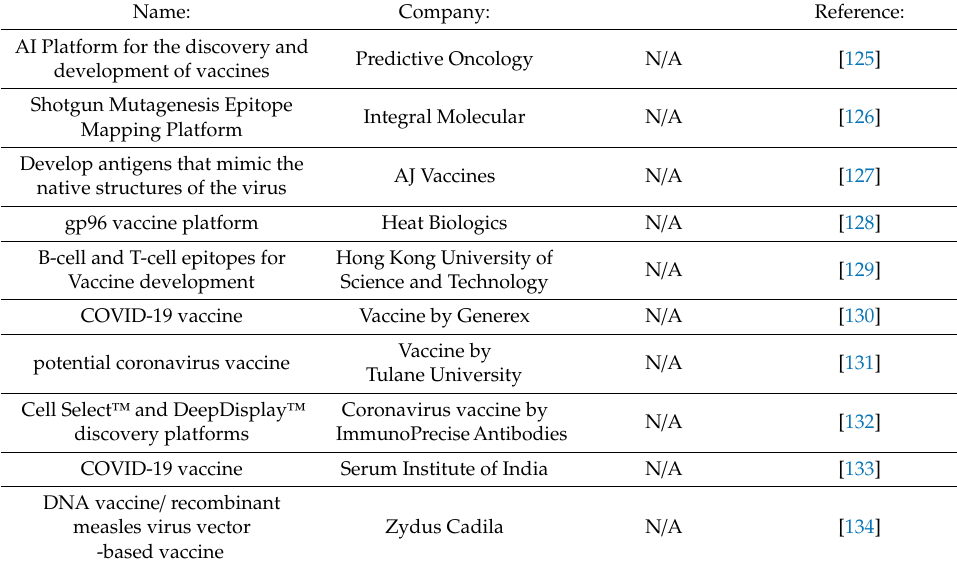
Figure S. Sequence alignment of the S protein of SARS-CoV-2 and SARS-CoV, Figure S2. Sequence alignment of the S protein of SARS-CoV-2 and MERS-CoV., Figure S3. Sequence alignment of the M protein of SARS-CoV-2